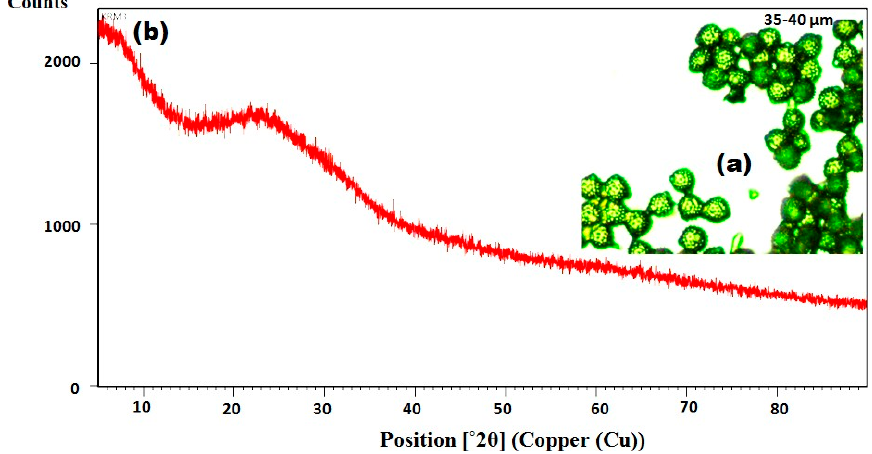
Figure 2. ( a ) Microscopic image and ( b ) XRD pattern of double-petal H. rosa-sinensis pollen.